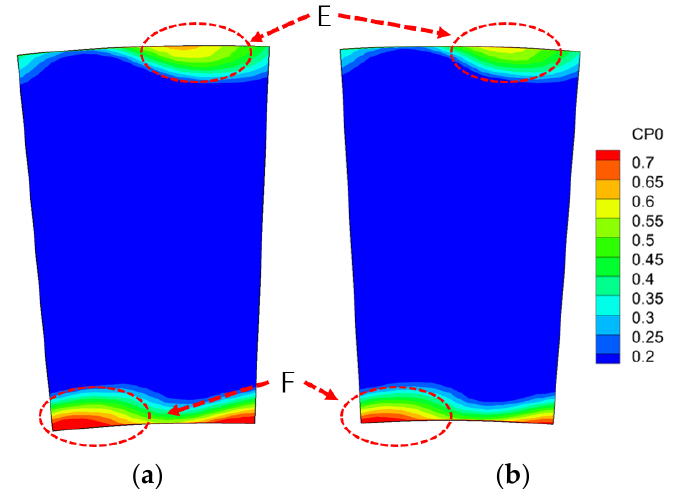
Figure 7. Stagnation pressure coefficient on the vane exit surface. ( a ) Datum ( b ) Convex.